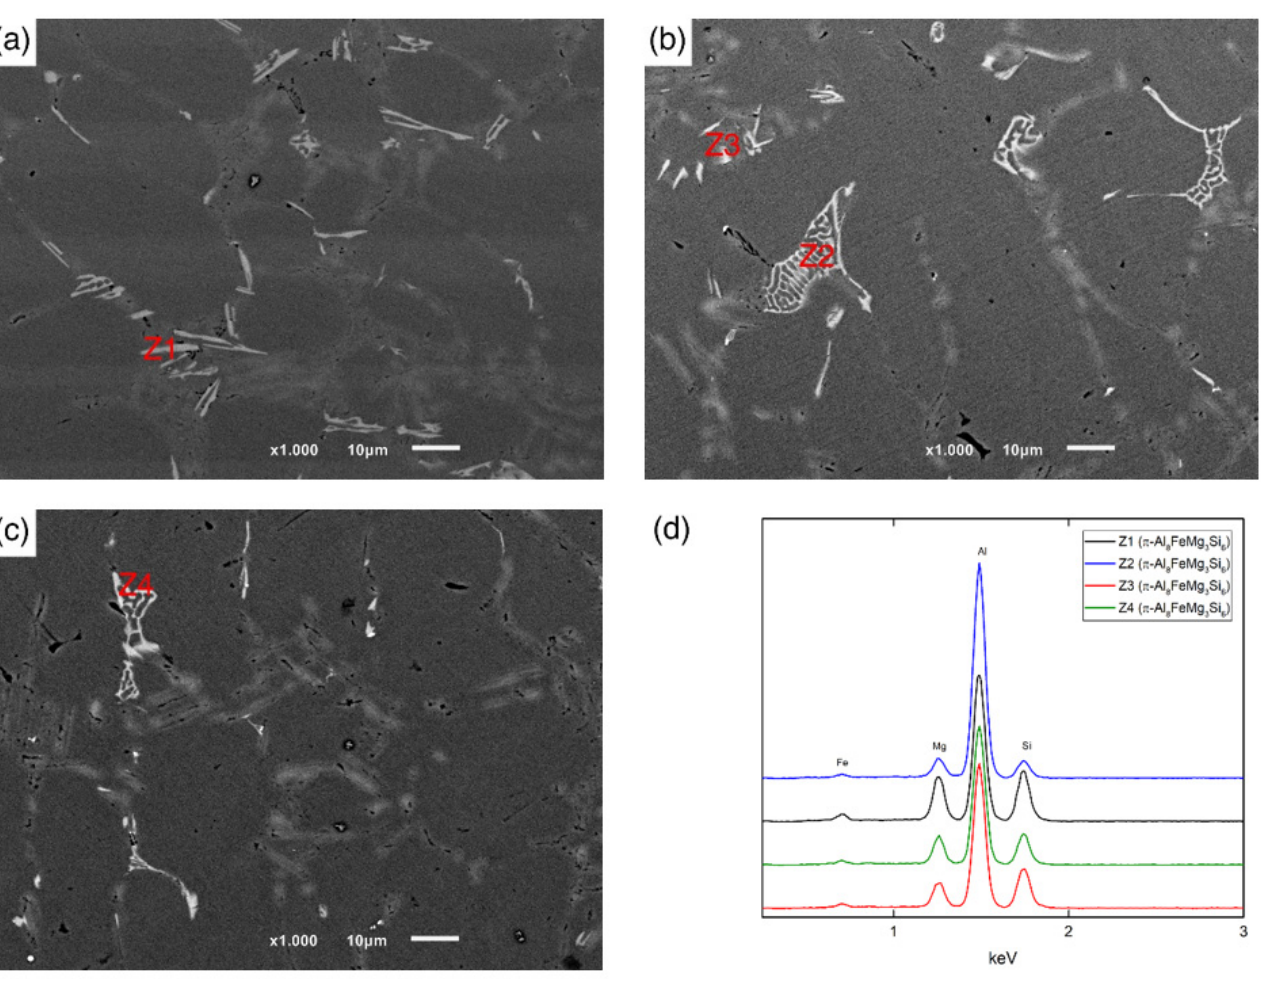
Figure 5. SEM micrographs (BSE mode) of the microstructures of samples ( a ) sample A; ( b ) sample B; ( c ) sample C. ( d ) EDS of corresponding intermetallic identified as Z1, Z2, Z3, and Z4, suggesting the overlapping phase composition. (magnification ×1000).